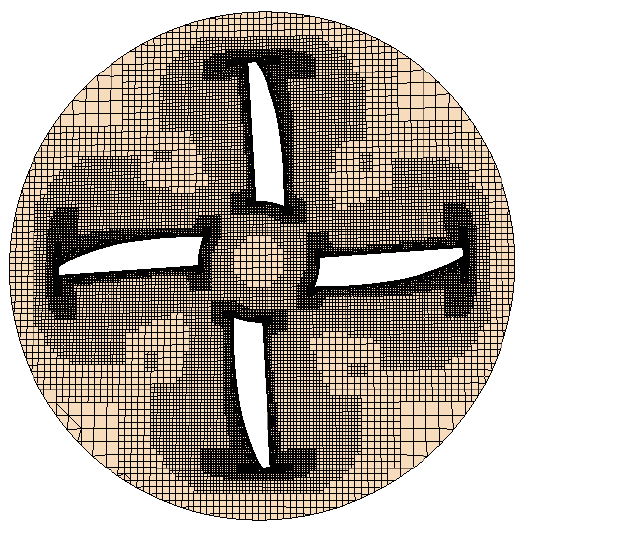
Figure 4. Propeller meshing diagram: ( a ) X section grid; ( b ) Y section grid.